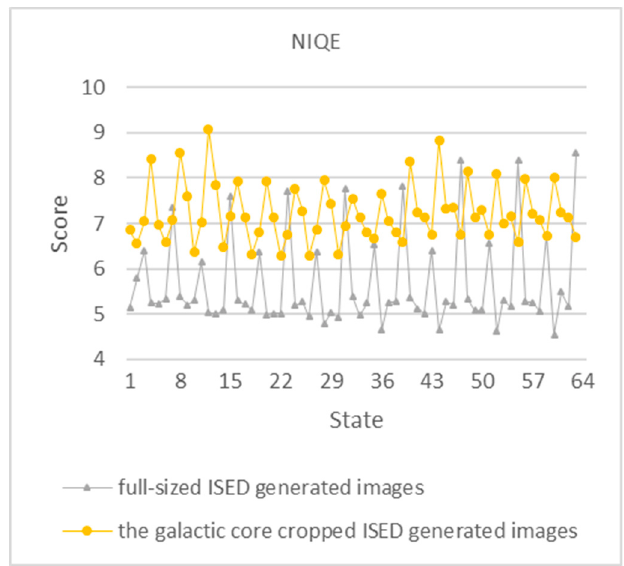
Figure 13. NIQE values of 63 ISED-generated images. The cropped images of M87 can be seen in Figure 9.